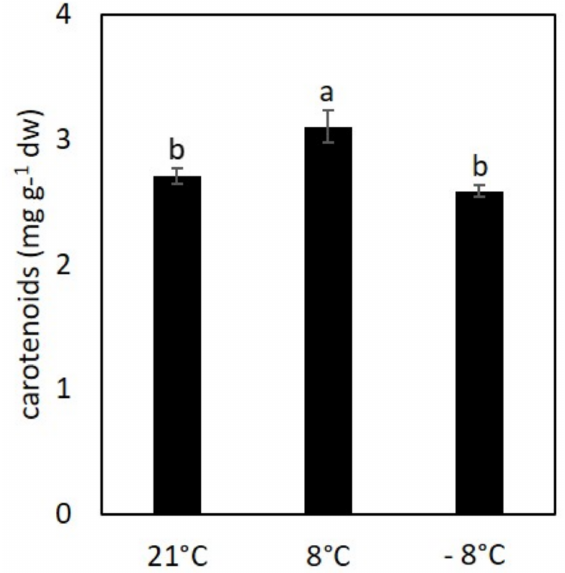
Figure 4. The content of carotenoids in kale exposed to low temperatures. Value marked with different letters are significantly different at p <